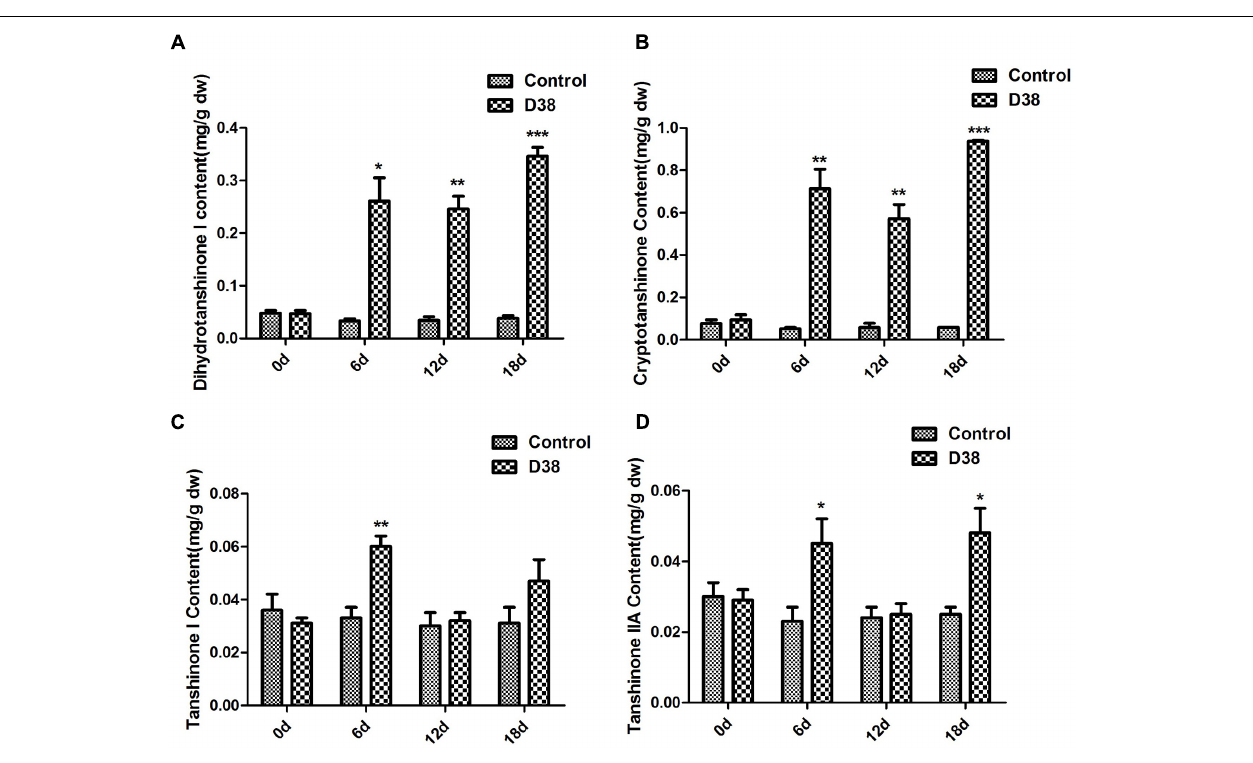
were observed for D38 on the contents of tanshinone I (T-I) and tanshinone IIA (T-IIA). D38 only increased the content of tanshinone I on day 6 (1.8 fold vs. control)